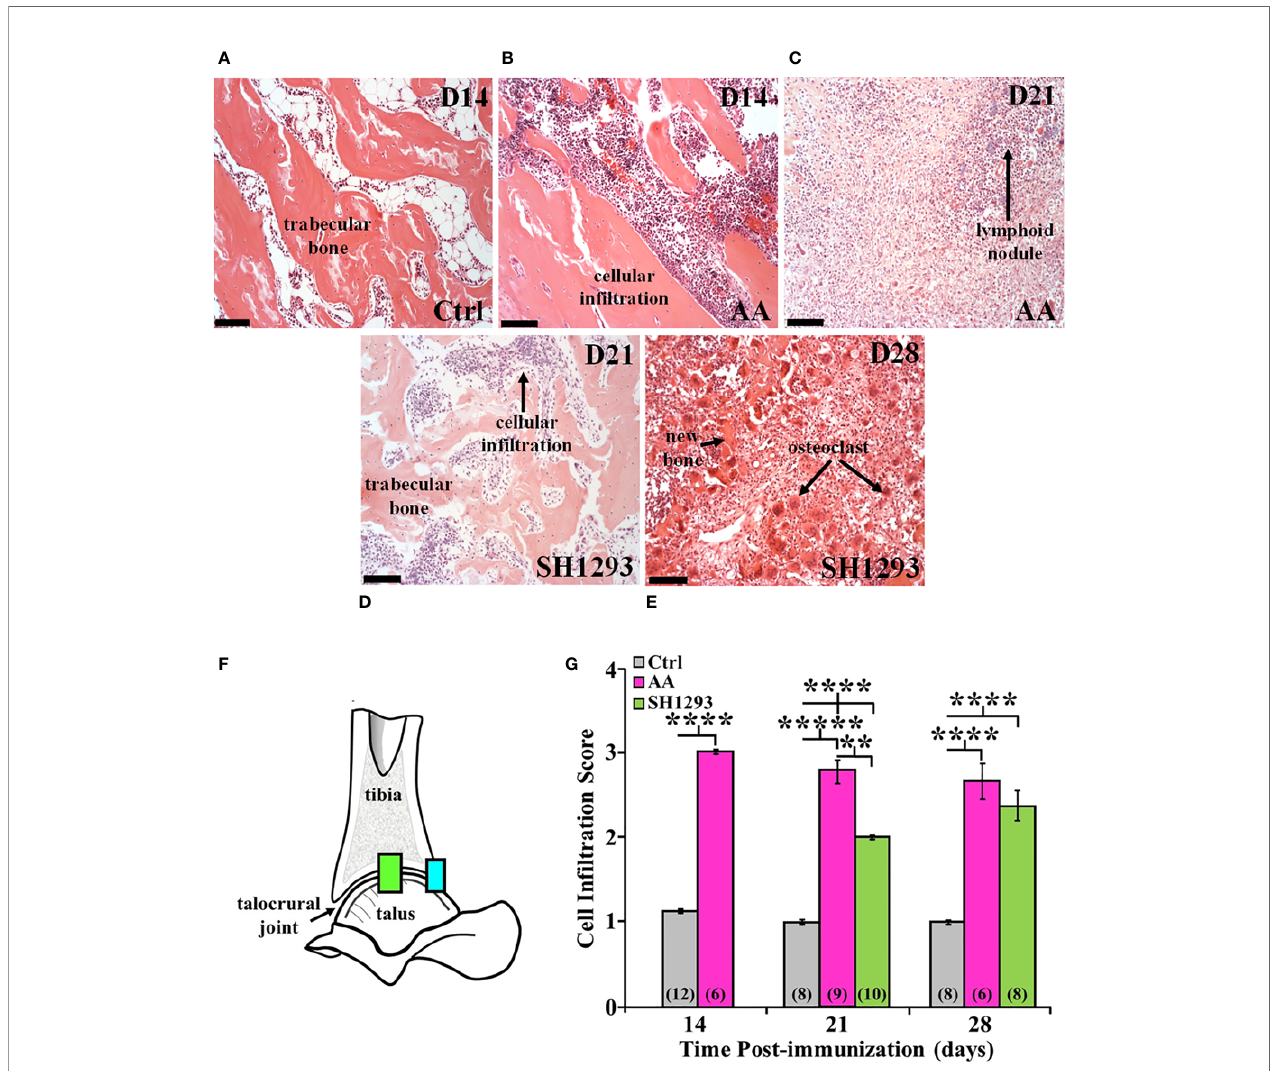
FIGURE 4 | SH1293 Suppresses Cellular In fi ltration into the Distal Tibia and Proximal Talus of Arthritic Rats. H&E images from the distal tibia and proximal talus of Ctrl, AA, and SH1293 rats revealed striking differences in in fl ammatory cell in fi ltration among the trabeculae in the bone marrow spaces between experimental groups. Calibration bars = 100 µm. (A) In Ctrl rats, trabecular bone in the distal tibia just proximal to the subcortical bone was intact and appeared normal with a sparse presence of leukocytes. (B) On D14, in the distal tibia of vehicle treated AA rats, trabecular bone was intact, however, leukocyte migration into the bone tissue was apparent as shown here. (C) By D21, extensive trabecular bone resorption was accompanied by extensive cellular in fi ltration in AA rats. (D) On D21, trabecular bone was preserved to a greater extent in SH1293 rats compared with AA rats at this time point. Cellular in fi ltration was apparent, but its magnitude was comparable to that in AA rats on D14. (E) By D28, trabecular bone resorption is more evident in SH1293 rats and consistent with a greater presence of osteoclasts. In fl ammatory leukocytes are present in greater numbers compared with rats treated with SH1293 at D21. (F) Morphometric analysis was completed at two evaluation sites within the talocrural joint, as illustrated in this diagram. (G) Cellular in fi ltration was scored and graphed across time after immunization in days. The numbers in parentheses in each bar indicate the number of rats per group. Asterisks mark statistically signi fi cant differences ( ** p < 0.01, **** p <